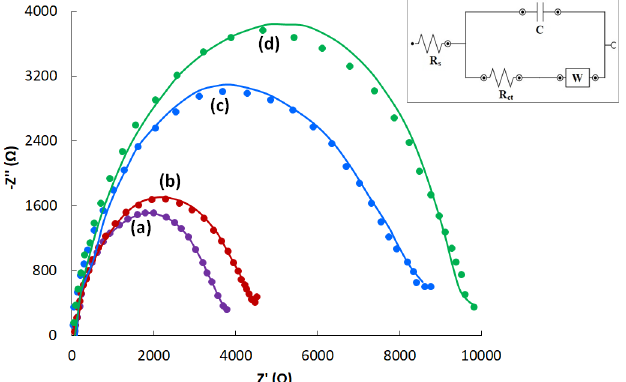
Figure 2. Experimental (points) and fitted (lines) Nyquist plots for CVE act at 2.0 V ( a ), 1.6 V ( b ), 1.0 ( c ) and CVE ( d ) in 0.1 M KCl containing 1.0 mM [Fe(CN) 6 ] 3 − /4 − . Insert: the diagram of an Randles V ( c ) and CVE ( d ) in 0.1 M KCl containing 1.0 mM [Fe(CN) 6 ] 3−/4− . Insert: the diagram of an Randles equivalent cell. equivalent cell.